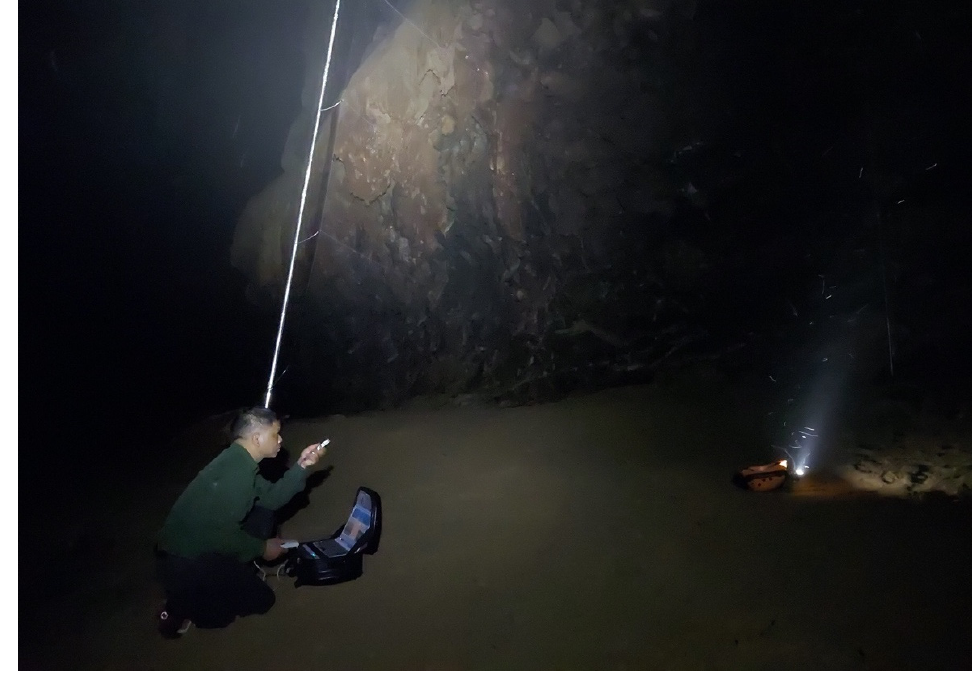
Figure 2. Echolocation recording beside a mist netting site inside Son Doong Cave.